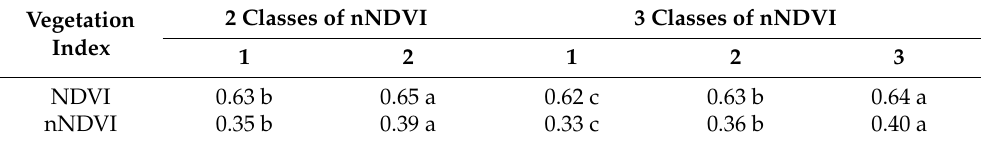
Figure 6. (a) interpolated nNDVI; ( b ) 2 clusters of nNDVI; ( c ) 3 clusters of nNDVI. Table 6. Analysis of variance (ANOVA) of NDVI and nNDVI according to nNDVI classes as result of k ‐ means clustering. Different letters (a, b; or a, b, c) indicate different groups with a p ‐ value < 0.01. Vegetation Index 2 Classes of nNDVI